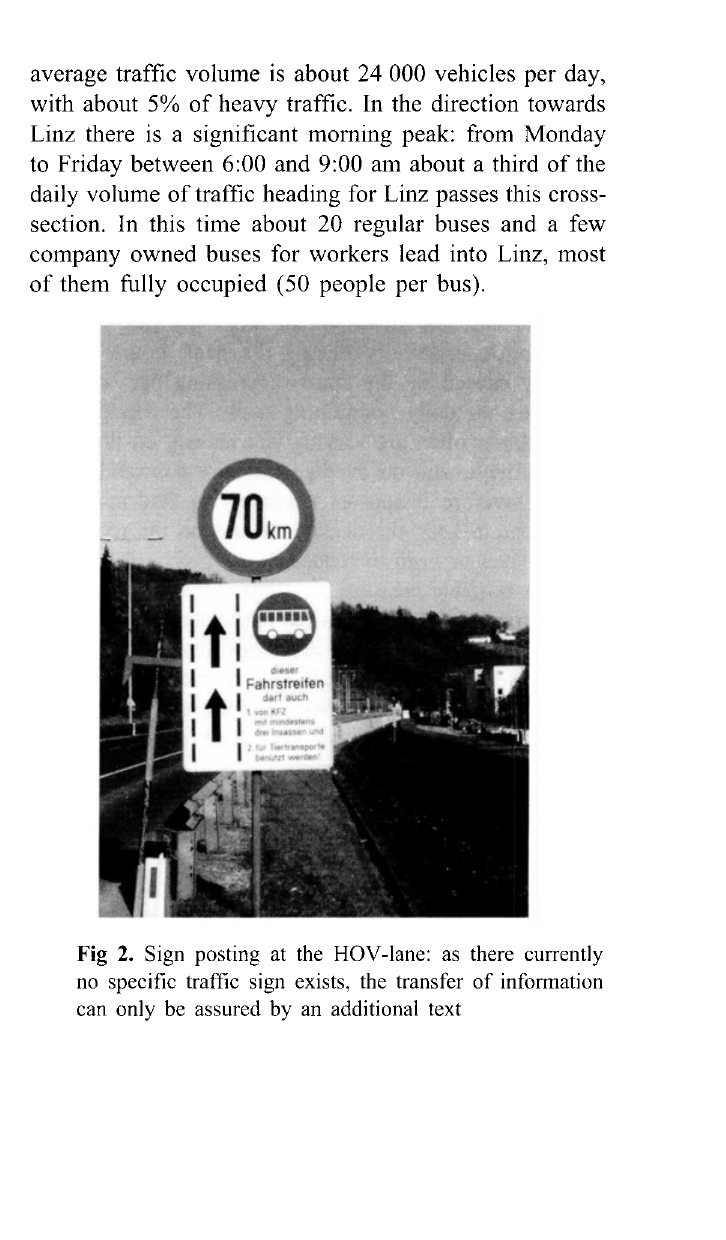
Fig 2. Sign posting at the HOY-lane: as there currently no specific traffic sign exists, the transfer of information can only be assured by an additional